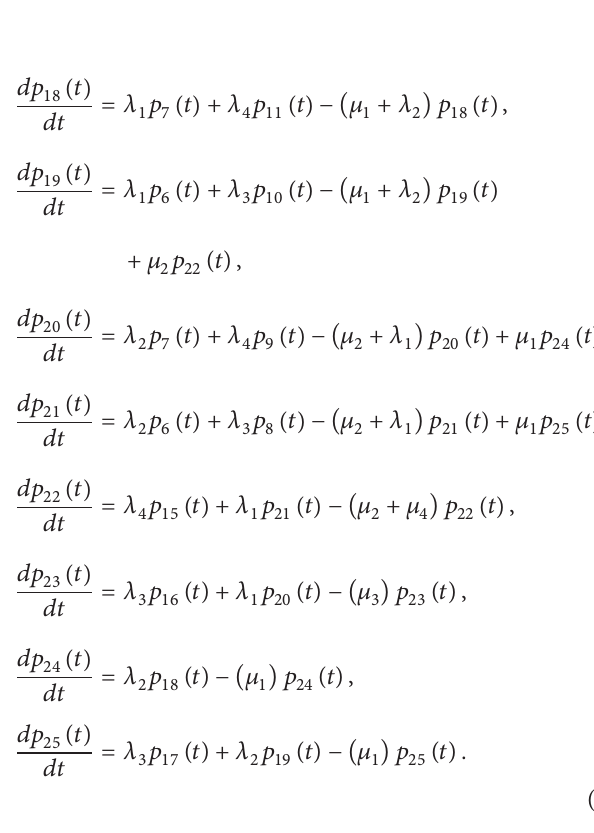
Figure 2: Markov state transition diagram: four-component system with a